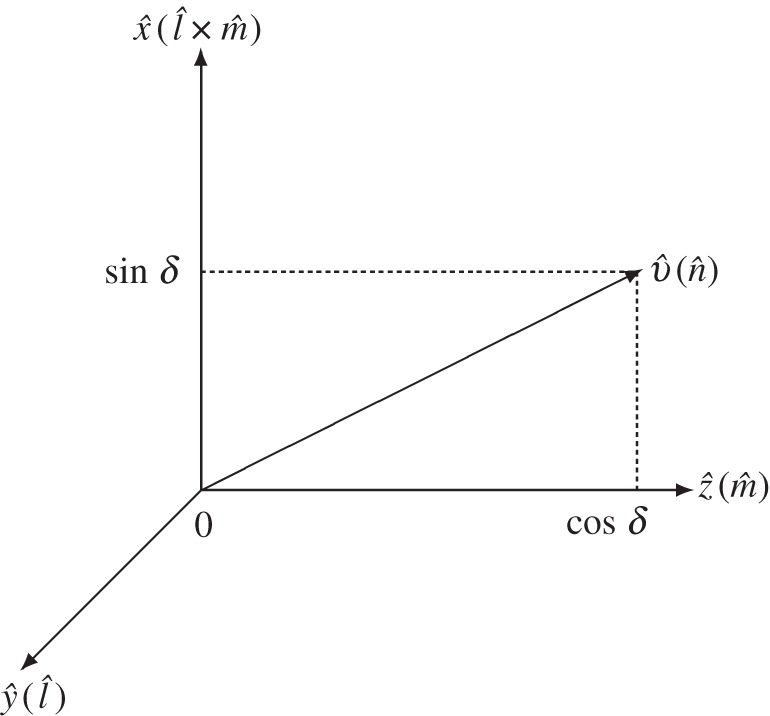
Configuration of l^,m^ and n^ in propositions 4.4 and 4.7, and configuration of y^=(0,1,0)T, z^=(0,0,1)T and v^ in arguments around these propositions.